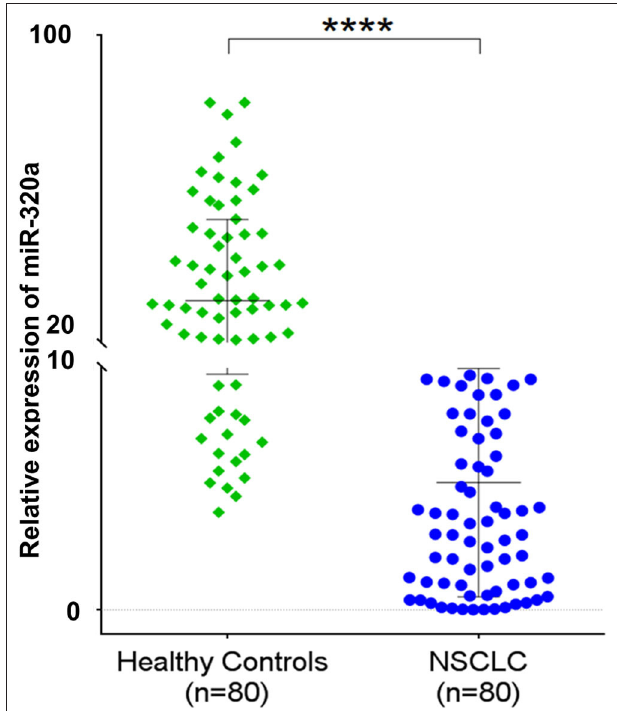
FIGURE 1 | Scatter plot represents a relative expression of circulating miR-320a in plasma samples of NSCLC patients compared to healthy controls. The data are expressed as mean ± SD obtained from at least n = 3 independent qRT-PCR experiments. **** p < 0.0001 calculated using an unpaired t-